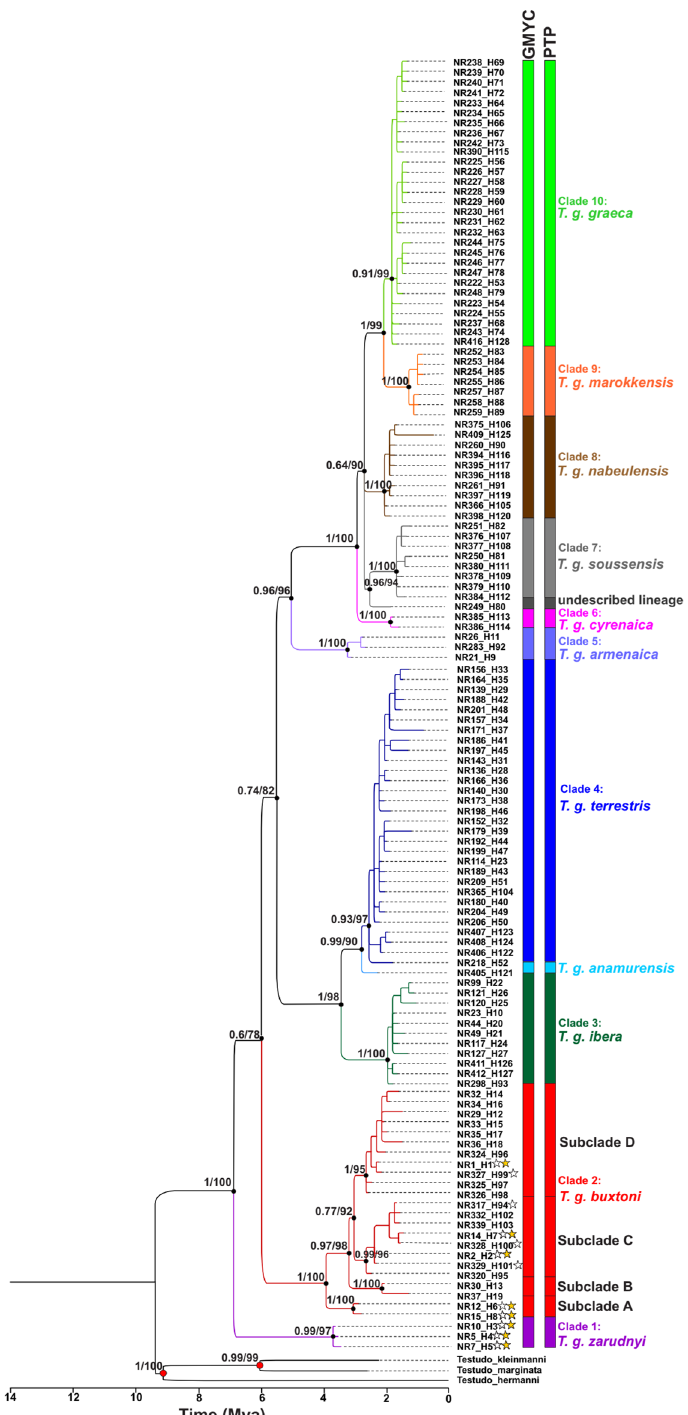
Figure 2. Phylogenetic relationships of Testudo graeca based on the 948-bp mtDNA cyt b gene sequences and rooted with T. kleinmanni (AJ888371), T. marginata (AJ888333), and T. hermanni (AJ888362). The identical topology derived from Bayesian inference (BI) summarized with 50% majority rule consensus tree and the best tree of maximum likelihood (ML) with species delimitation analyses using Poisson Tree Processes (PTP) and General Mixed Yule Coalescent (GMYC) methods. The numbers on nodes represent posterior probabilities in BI and bootstrap values in ML, respectively. The main clades recognized as subspecies according to Fritz et al. 3,4 and Mashkaryan et al. 8 . Stars indicate haplotypes detected in the contact zone between clades 1 and